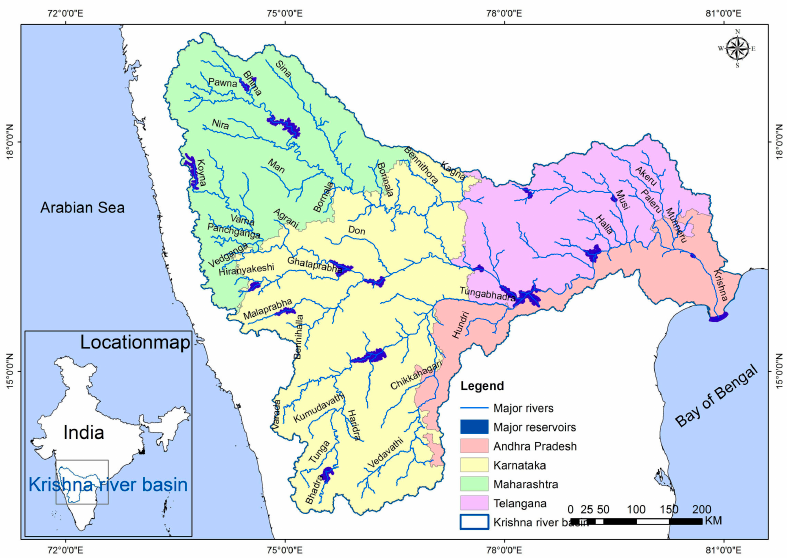
Figure 1. Map of the study area with a location map.